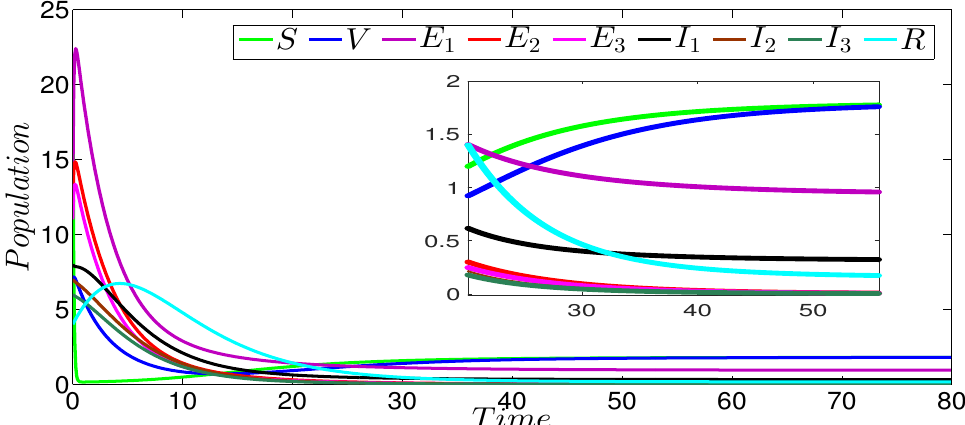
Figure 3. Stability of the strain-1 endemic equilibrium E s = 1.38, R 2 = 0.82 and R 3 = R 1 0 0 0